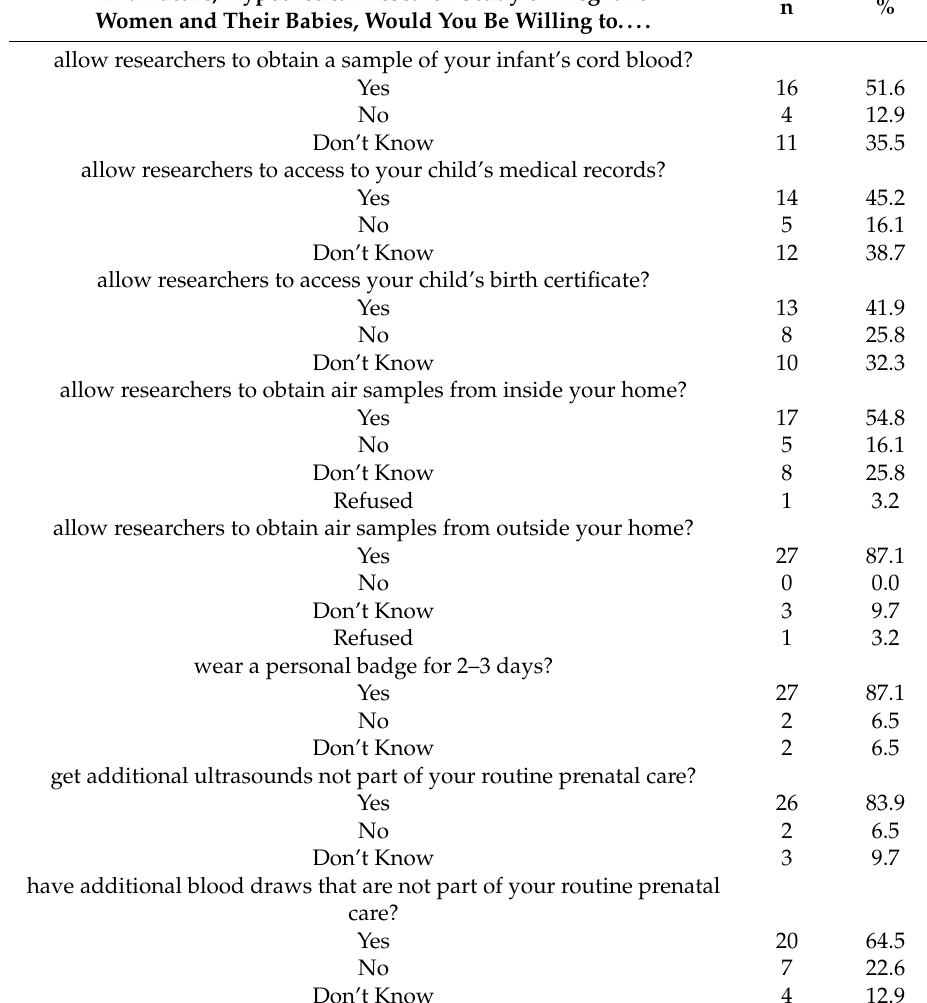
Table 2. Willingness to participate in various future hypothetical study scenarios among 31 pregnant women attending a prenatal health clinic serving primarily Medicaid patients. In a Future, Hypothetical Research Study of Pregnant n % Women and Their Babies, Would You Be Willing to.... allow researchers to obtain a sample of your infant’s cord blood? Yes